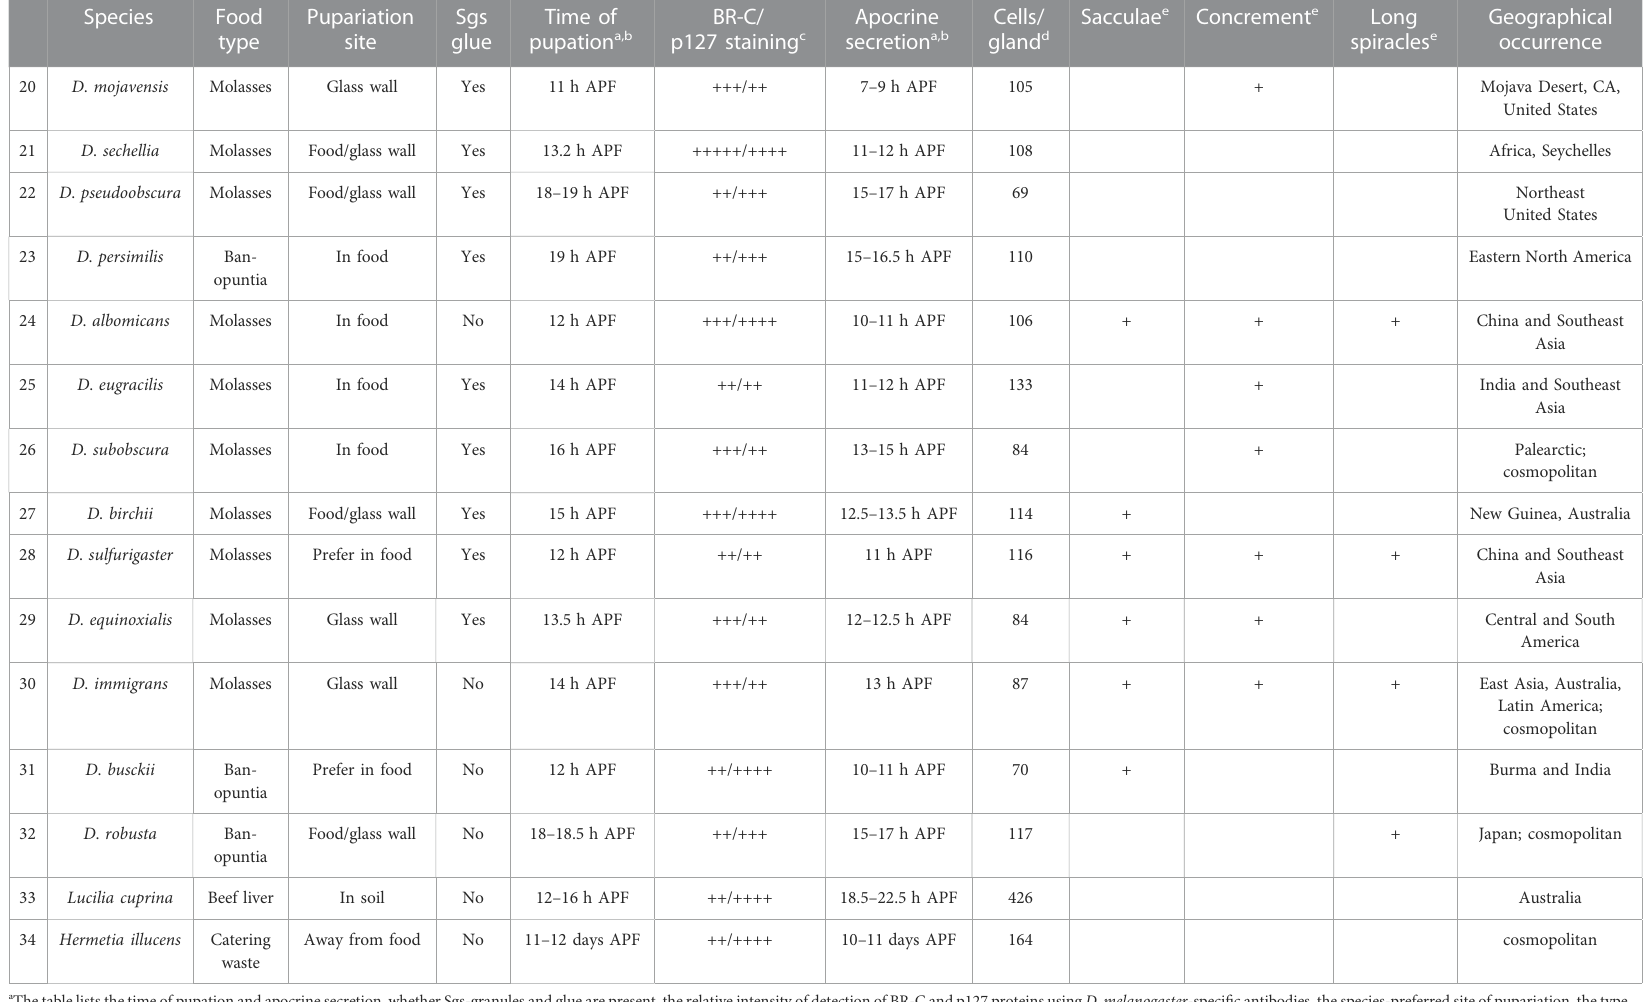
species. b The times of pupation and apocrine secretion for a species are the range of times seen in three sets of observations, each having a minimum of 30 animals. c Therelativeintensityof fl uorescenceisdepicted bythenumberofplus(+)signsforeachoftheproteins,where fi vepluses(+++++)representsthestrongestsignal,asignalequaltothatfoundin D . melanogaster ,andasingleplus(+)indicatestheweakest signal. d The number of secretory cells for a species is the arithmetic means of cell counts obtained using a fl uorescent microscope and a 20× objective lens for a minimum of 15 pairs of SGs from each species, in triplicate. e A single plus (+) indicates the presence of collector sacculae, the presence of concrements, or the formation of long spiracles during pupariation. An empty cell in these columns indicates the absence of collector sacculae, concrements, or long spiracles. Negative signs (-) were not used for